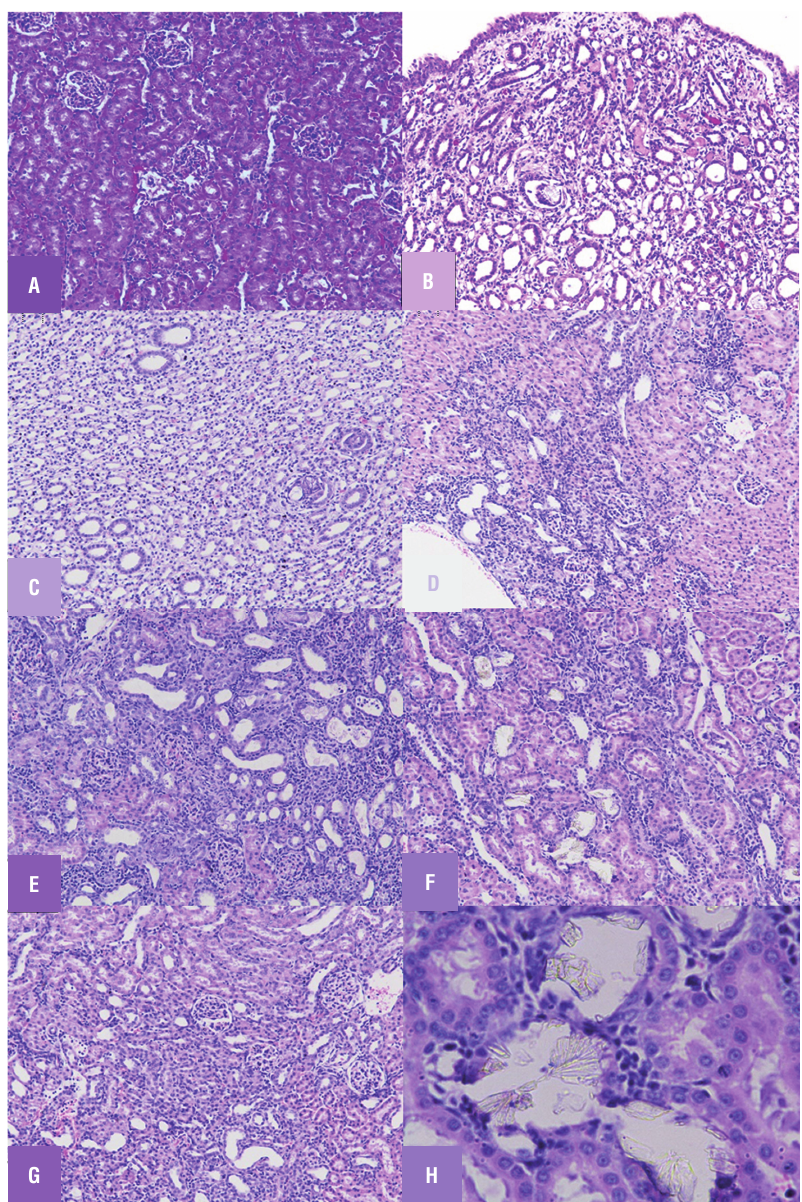
figure 1 - Light microscopic architecture of kidney showing (A) Renal tissue of control (group 1) rats showing no sign of crystal deposition. (B) Renal tissue of urolithiatic rats (group 2) showing crystals deposition and severe obstructive nephropathy (C) Renal tissue of (group 3) sTs treated rats showing mild crystal deposition with mild nephropathy. (D) Renal tissue of (group 4) diazoxide treated rats showing mild crystal deposition with moderate obstructive nephropathy (E) Renal tissue of (group 5) glibenclamide treated rats showing prominent crystal deposition with severe obstructive nephropathy (f) Renal tissue of (group 6) diazoxide +sTs treated rats showing crystal deposition with severe obstructive nephropathy (g) Renal tissue of (group 7) glibenclamide + sTs pretreated rats low crystal deposition with mild nephropathy (h) Crystal's deposition as observed under 40X